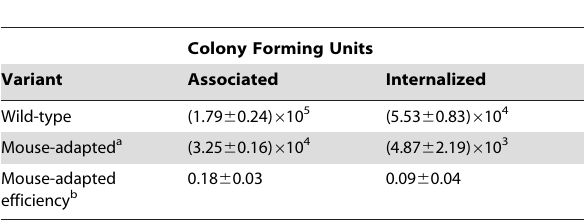
Table 4. Epithelial cell interaction of C. jejuni